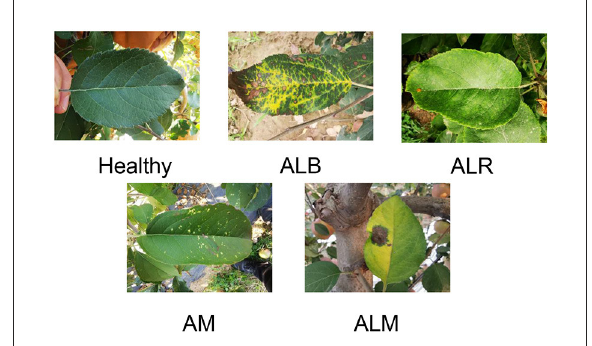
FIGURE1 Status and classification of the dataset.